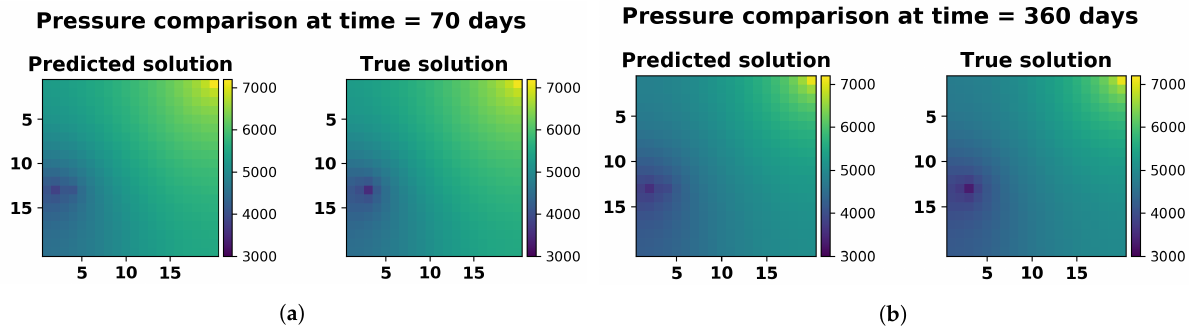
Figure 7. Pressure solution comparison at ( a ) Time = 70 days and ( b ) Time = 360